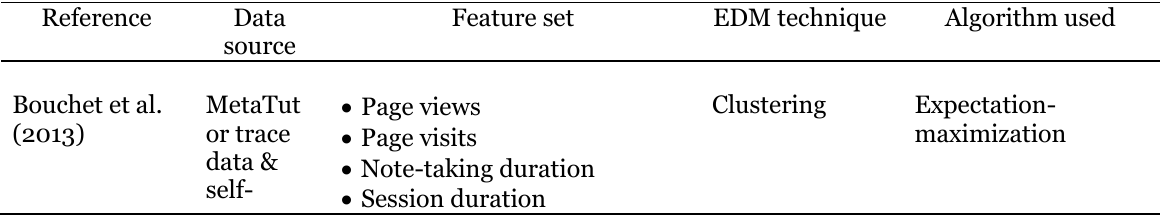
Algorithms Used to Measure SRL in Online Learning Environments